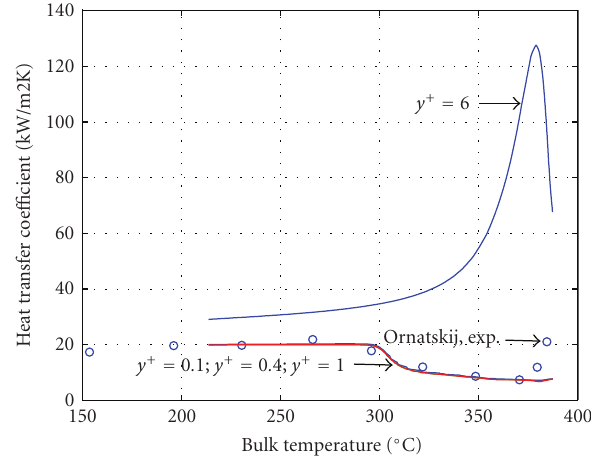
Figure 2: Sensitivity analysis on the grid size for the SST turbulence model, comparison with the experiment by Ornatskij et al. [3]. Flow conditions: p = 25 . 5MPa, d = 3mm, G = 1500 kg / m 2 s, q = 1810 kW / m 2 , vertical upward flow in a